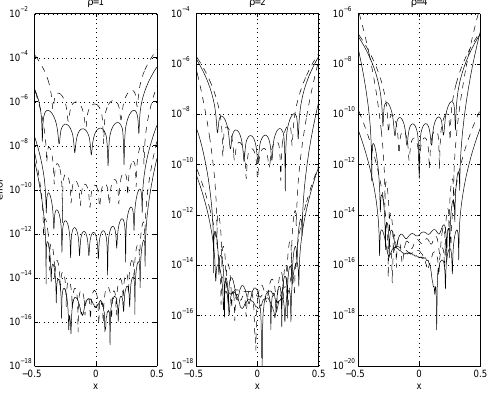
Figure 19. Errors for the Gegenbauer reconstruction of the function f ( x ) defined by (6.2) for ρ = 1 , 2 , and 4 and m = 6 , 12 , and 18 , with parameters α opt,R , N opt,R (solid lines) and α opt,ρ , N opt,ρ (dashed lines); these parameters are listed in Table 1 and Table 2.